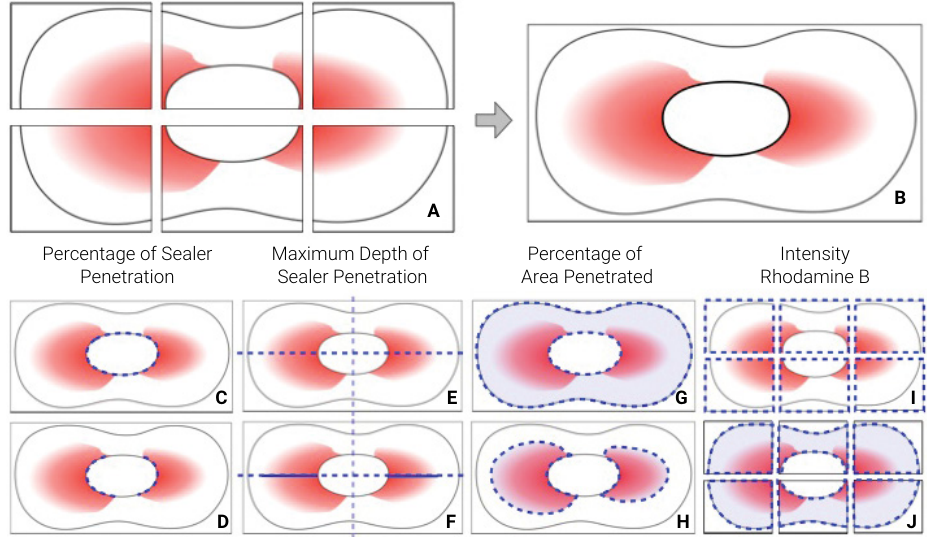
Figure 1. Design evaluation parameters of each radicular section. (A) Captured images in CLSM; (B) Merged image at Image J software; (C) Root canal wall perimeter; (D) Root canal wall perimeter covered by sealer; (E) Four standardized points on each image; (F) Maximum depth sealer penetration; (G) Area of each section; (H) Area penetrated with sealer; (I) Intensity values of rhodamine B and (J) Dentin area outlined and rhodamine B